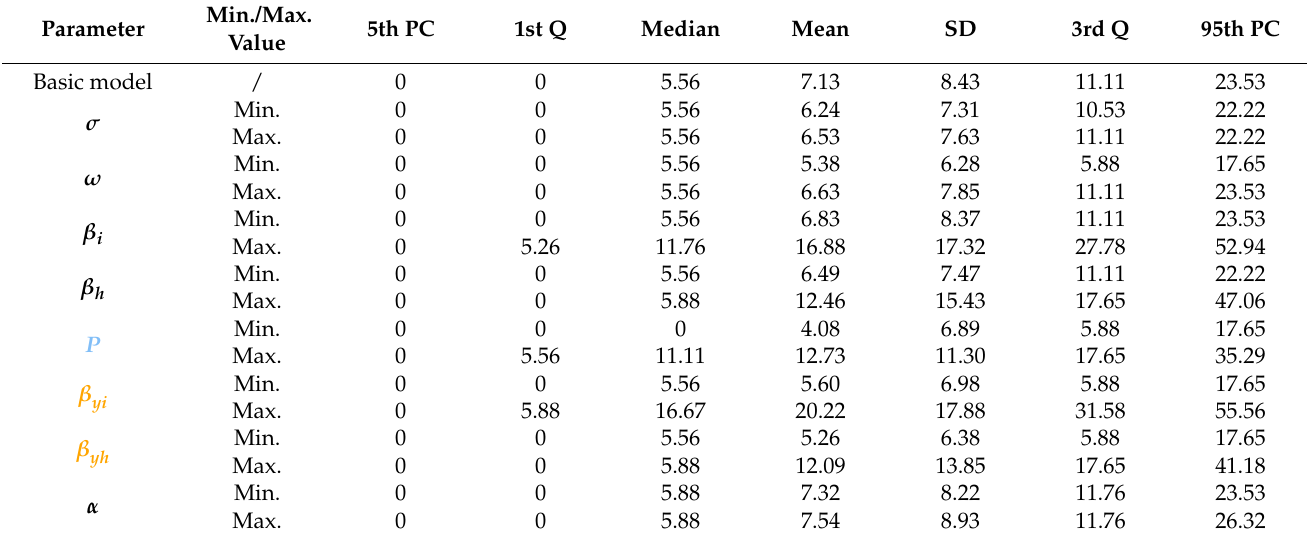
Table 4. Results of the prevalence of Mycobacterium avium subsp. paratuberculosis within the herd from the sensitivity analysis of the epidemiologically most significant parameters. The parameters and their values in the basic model and the sensitivity analysis are defined in Table 3. Percentile, PC; quantile, Q; standard deviation,